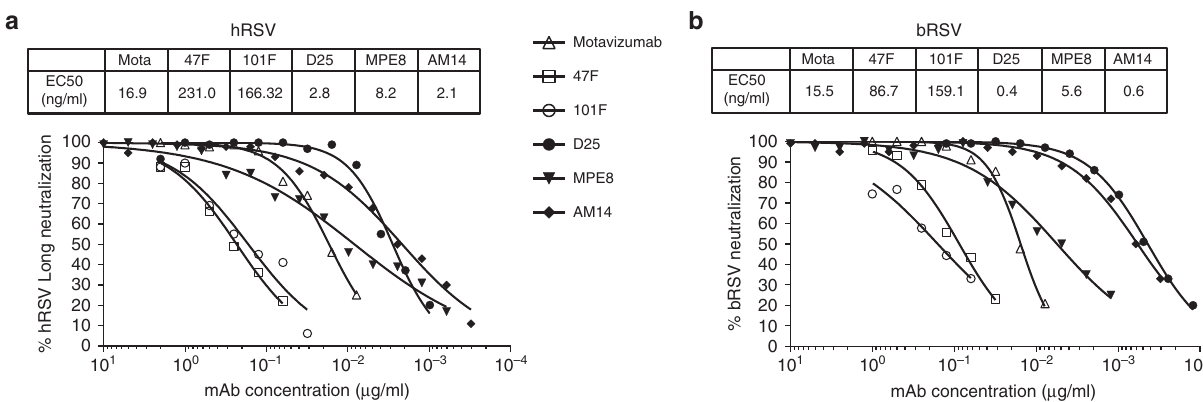
Fig. 2 Neutralizing activity of different monoclonal antibodies targeting the RSV F protein. a hRSV; ( b ) bRSV. Effective concentrations (EC50) for each of the antibodies are indicated above the graphs (in ng/ml).